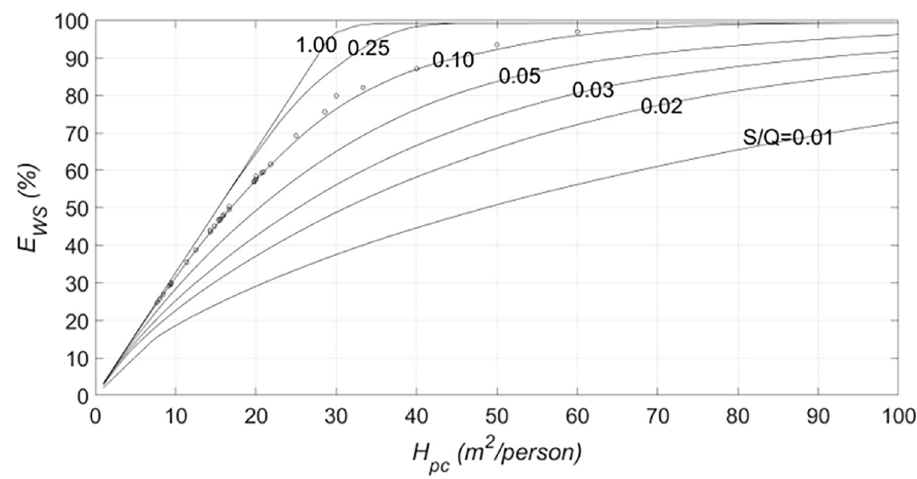
Fig 4. Water saving efficiency as a function of the roof area per capita for different storage fraction values. The dots represent the performances of the representative buildings.